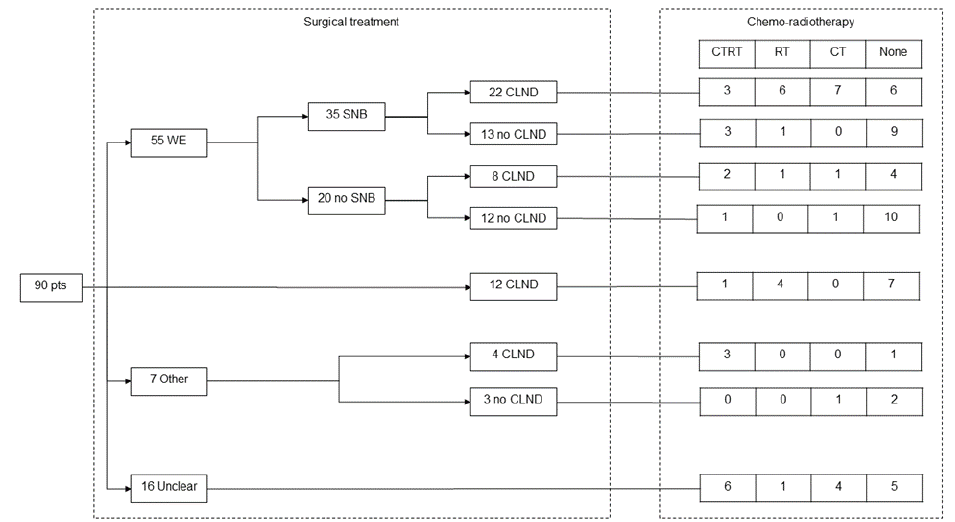
Figure 2. Surgical treatment and chemo-radiotherapy.